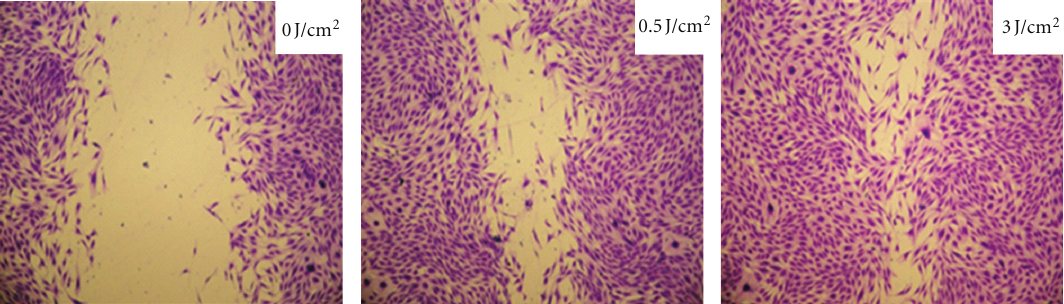
Figure 1: Photomicrographs showing human gingival fibroblast cultures seeded in 24-well plates after LLLT. The control group exhibits a large cell-free area on acrylic surface. The group irradiated with 0.5J/cm 2 exhibits cell proliferation and migration, with consequent reduction of the “in vitro wound” size. The group irradiated with 3.0J/cm 2 presented more intense cell proliferation and migration, resulting in almost complete closure of the “in vitro wound.”